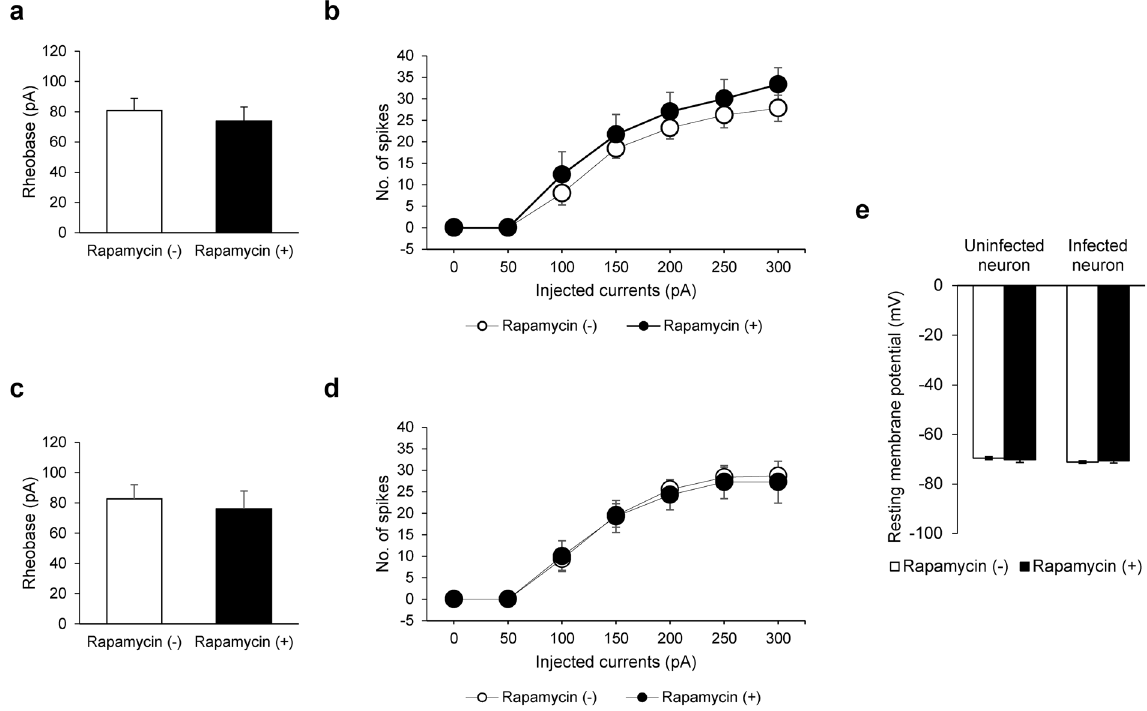
Figure 3. Lack of effect of rapamycin or acute reduction of PIP 2 on neuronal excitability. ( a ) Mean rheobases in uninfected CA1 neurons with and without rapamycin (Rapamycin ( − ), 80.84 ± 8.02 pA, N = 4, n = 5 vs . Rapamycin ( + ), 73.80 ± 9.32 pA, N = 3, n = 6, p > 0.1, Mann-Whitney U-test). ( b ) The number of spike firings at the indicated current steps in uninfected CA1 neurons. ( c ) Mean rheobases in CA1 neurons expressing LDR-T2A-Inp54p with and without rapamycin. (Rapamycin ( − ), 82.67 ± 9.32 pA, N = 2, n = 5 vs . Rapamycin ( + ), 76.05 ± 11.8 pA, N = 2, n = 4, p > 0.1, Mann-Whitney U-test) ( d ) The number of spike firings at the indicated current steps in CA1 neurons expressing LDR-T2A-Inp54p. ( e ) Resting membrane potentials (RMPs) of hippocampal neurons before and after rapamycin treatment (Uninfected neurons: Rapamycin ( − ) − 69.55 ± 0.55 mV vs . Rapamycin ( + ) − 70.17 ± 1.12 mV, N = 3, n = 10, p > 0.1; Infected neurons: Rapamycin ( − ) − 71.11 ± 0.59 mV vs . Rapamycin ( + ) − 70.59 ± 0.97 mV, N = 3, n = 9, p > 0.1, Paired T-test). Error bars show mean ±